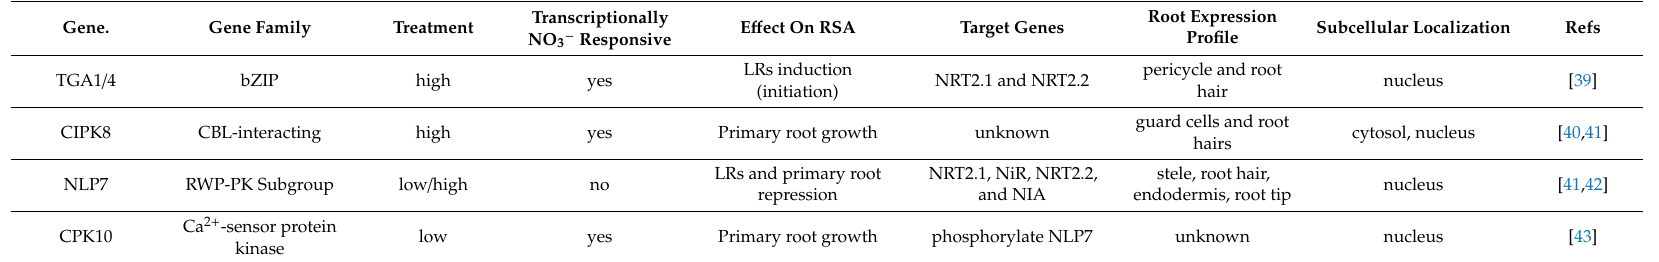
Table 2. Long Term and Short Term Nitrate Responsive